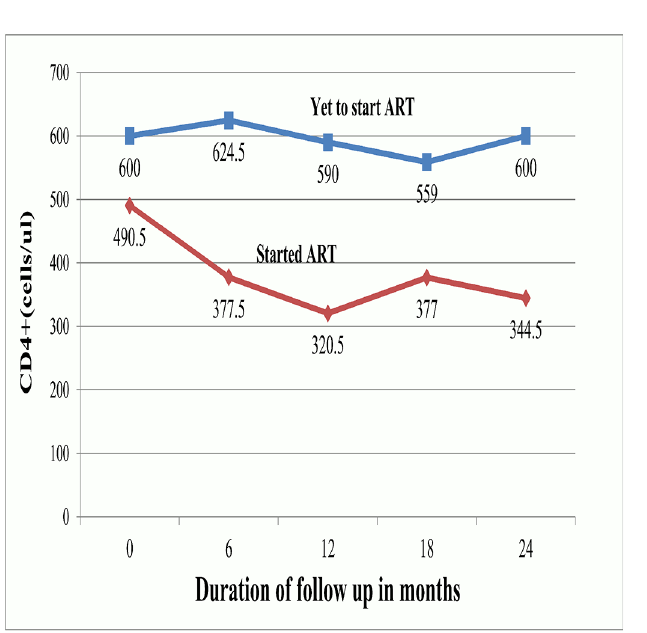
Fig 3. Temporal 6monthly median CD4 cell counts according to ART status. At each individual time points, the observed median CD4 cell counts were significantly higher in participants who were yet to start ART (p < 0.0001 at each indivudal time points of 0, 6, 12 and 24 months and p = 0.0001 at 18months; Mann Whitnet test). Among study participants who started ART, the graph shows a steep and progressive drop in median CD4 cell counts in the first year of follow up.